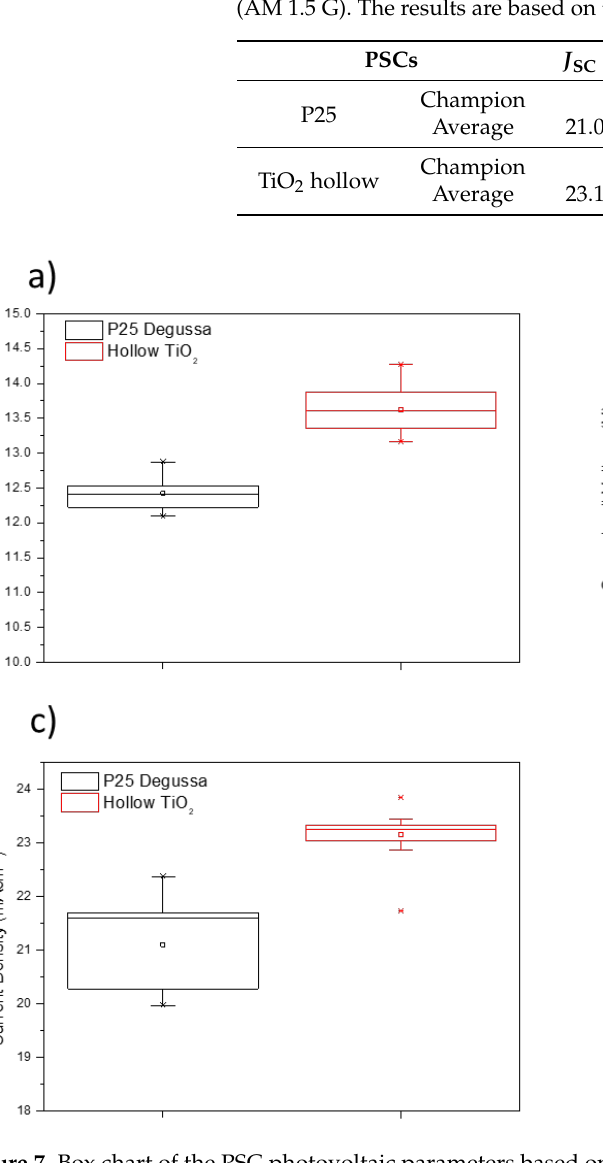
Figure 7. Box chart of the PSC photovoltaic parameters based on P25 and as-synthesized hollow TiO 2 nanospheres. The data was collected from 18 cells for each type. ( a ) PCE (%); ( b ) short circuit current density ( J SC ) (mAcm − 2 ); ( c ) fill factor (FF); ( d ) V OC (V).